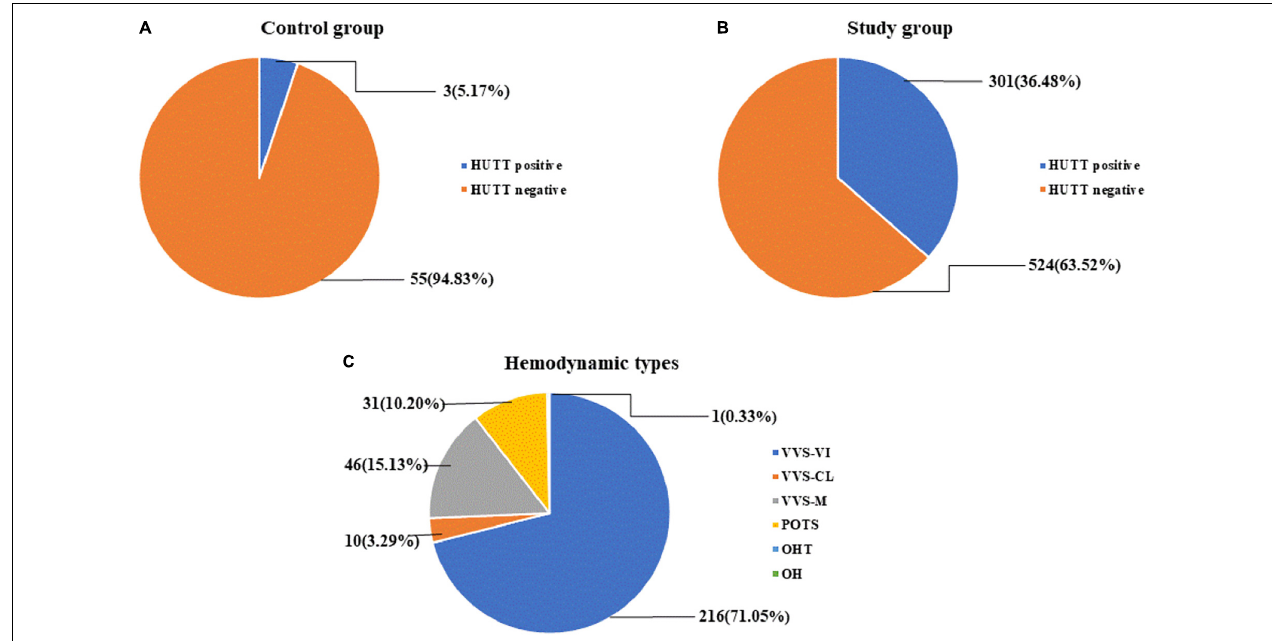
FIGURE 2 | HUTT results for each group and hemodynamic type [ n (%)]. (A) HUTT results of the control group. (B) HUTT results of the study group. (C) Hemodynamic type in HUTT.